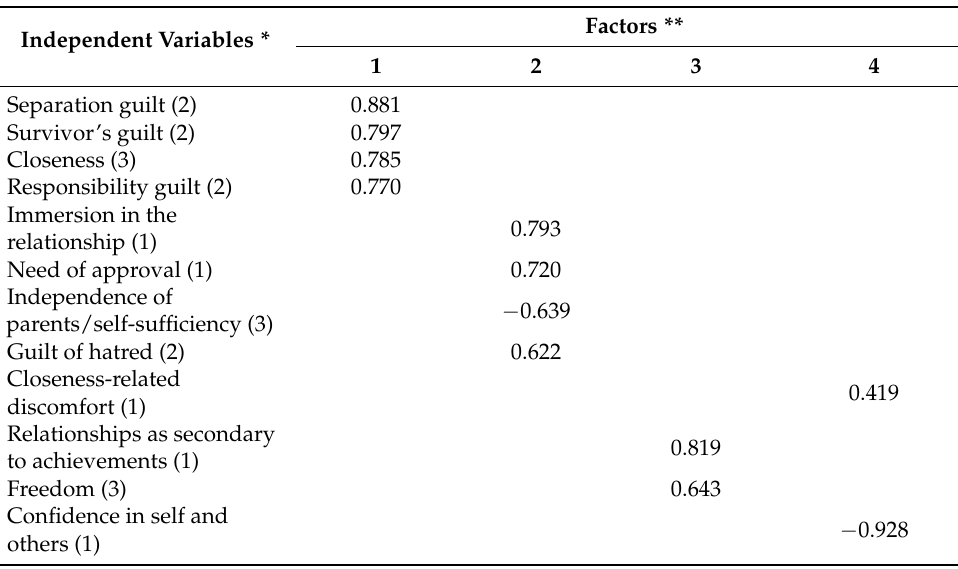
Table 1. Exploratory factor analysis results. Middle-aged women’s types of relations with their parents ( n =